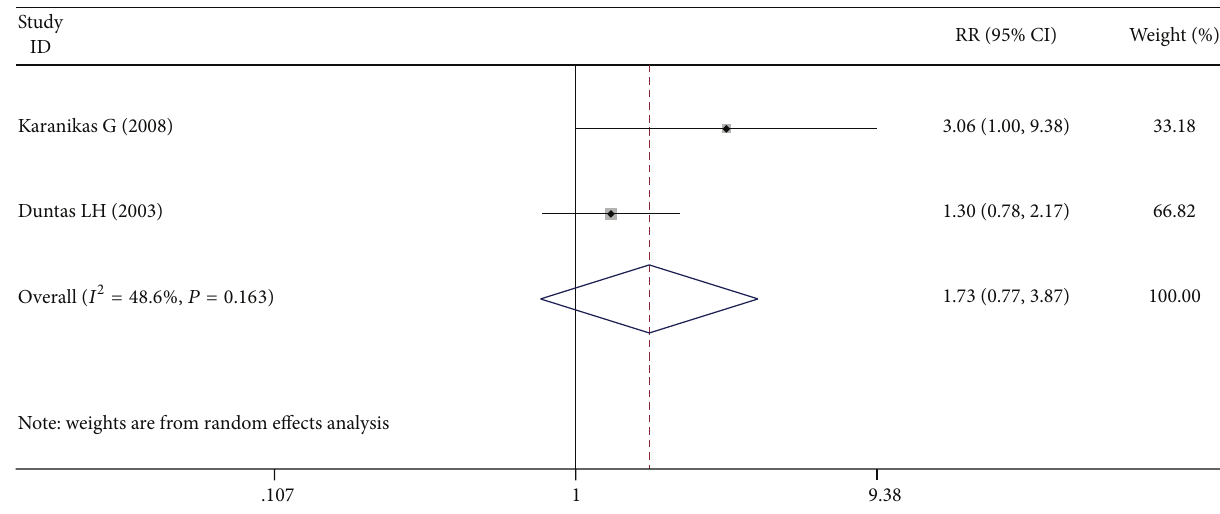
Figure 4: Forest plot showing the effects of Se supplementation on mood in patients of